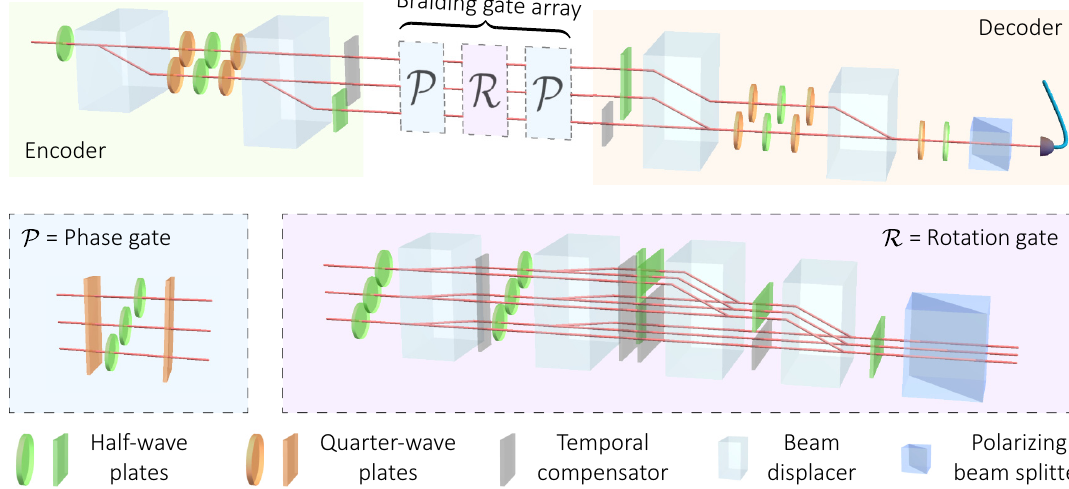
FIG. 2. The parafermion photonic simulator. The qutrit state, | ψ Pf (cid:2) , of the parafermion-edge zero modes is encoded on photonic paths. The preparation of the qutrit state in the encoder is implemented using arrays of beam displacers. The half-wave plates and quarter-wave plates are exploited to control the complex amplitude of each mode. The photonic modes are then subjected to the required braiding-evolution gates consisting of two phase gates, P inducing phase unitaries between the three modes and a rotation gate R inducing a generic SU ( 3 ) rotation. Then, the architecture of beam displacers is again exploited in the decoder to recover the status of the parafermion-edge zero modes by tomographic measurements. In the subplots with dashed boxes, we give the detailed photonic implementation of the P and R gates, where the individual modulation of the nine optical modes inside R is realized by additional amplitude filtering (not shown). Throughout the setup, we insert the temporal compensators to align the optical lengths of the modes so that the interference visibility is maximized and tilt them to introduce the necessary phase compensations. The brightness of the photon source in this experiment is about 100 000 counts/s on the maximum detection basis and the integration time is 10 s per data